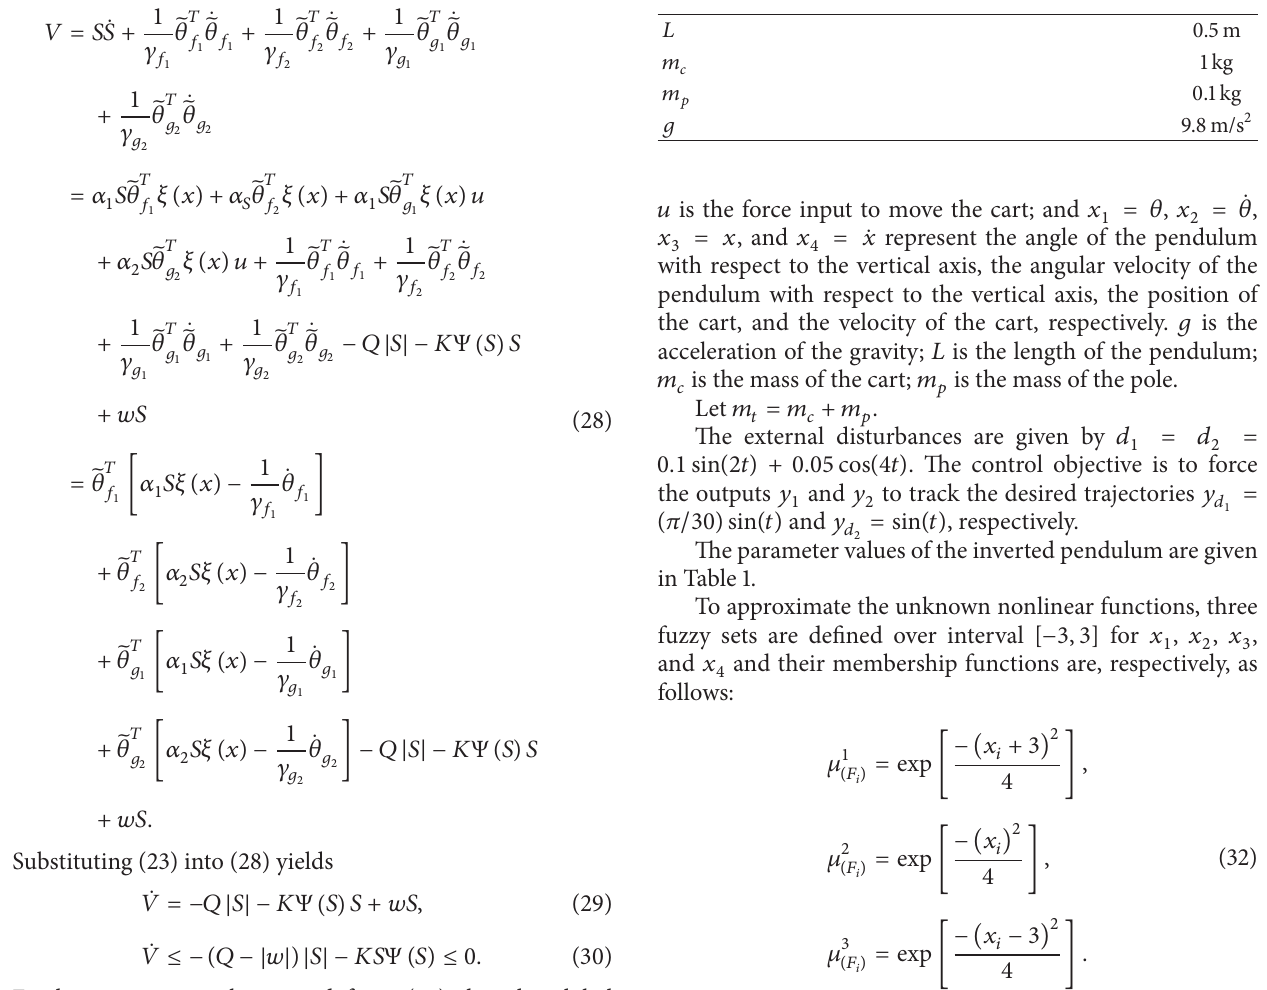
Table 1: Parameter values of the inverted